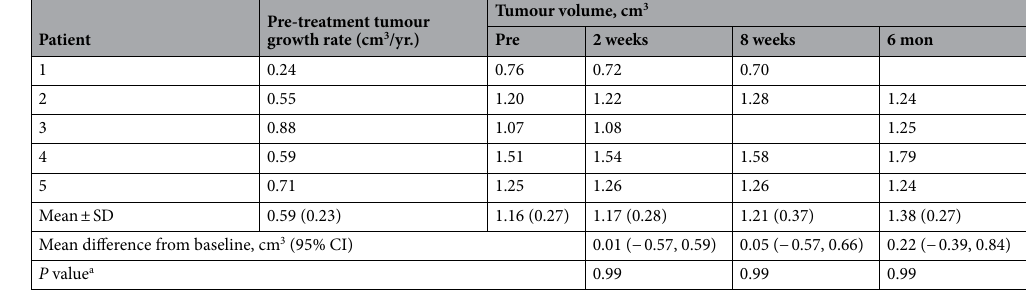
Table 2. Temporal changes in VS volume post-treatment. a Repeated measures mixed-effects model with post hoc pairwise comparison using the Bonferroni method. Acquired high spatial resolution T2W images (i.e., T2W-DRIVE) was used for all volume segmentations across all timepoints.